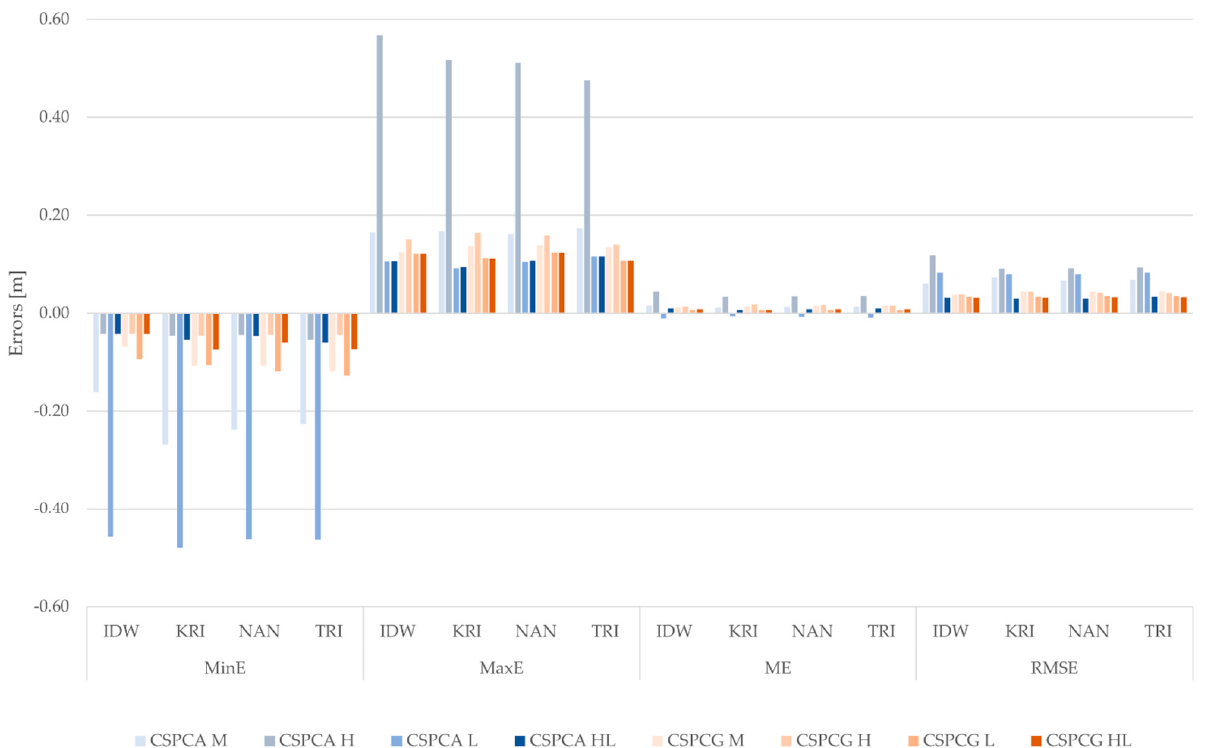
Figure 24. Summary of MinE, MaxE, ME, and RMSE for the analyzed tests.